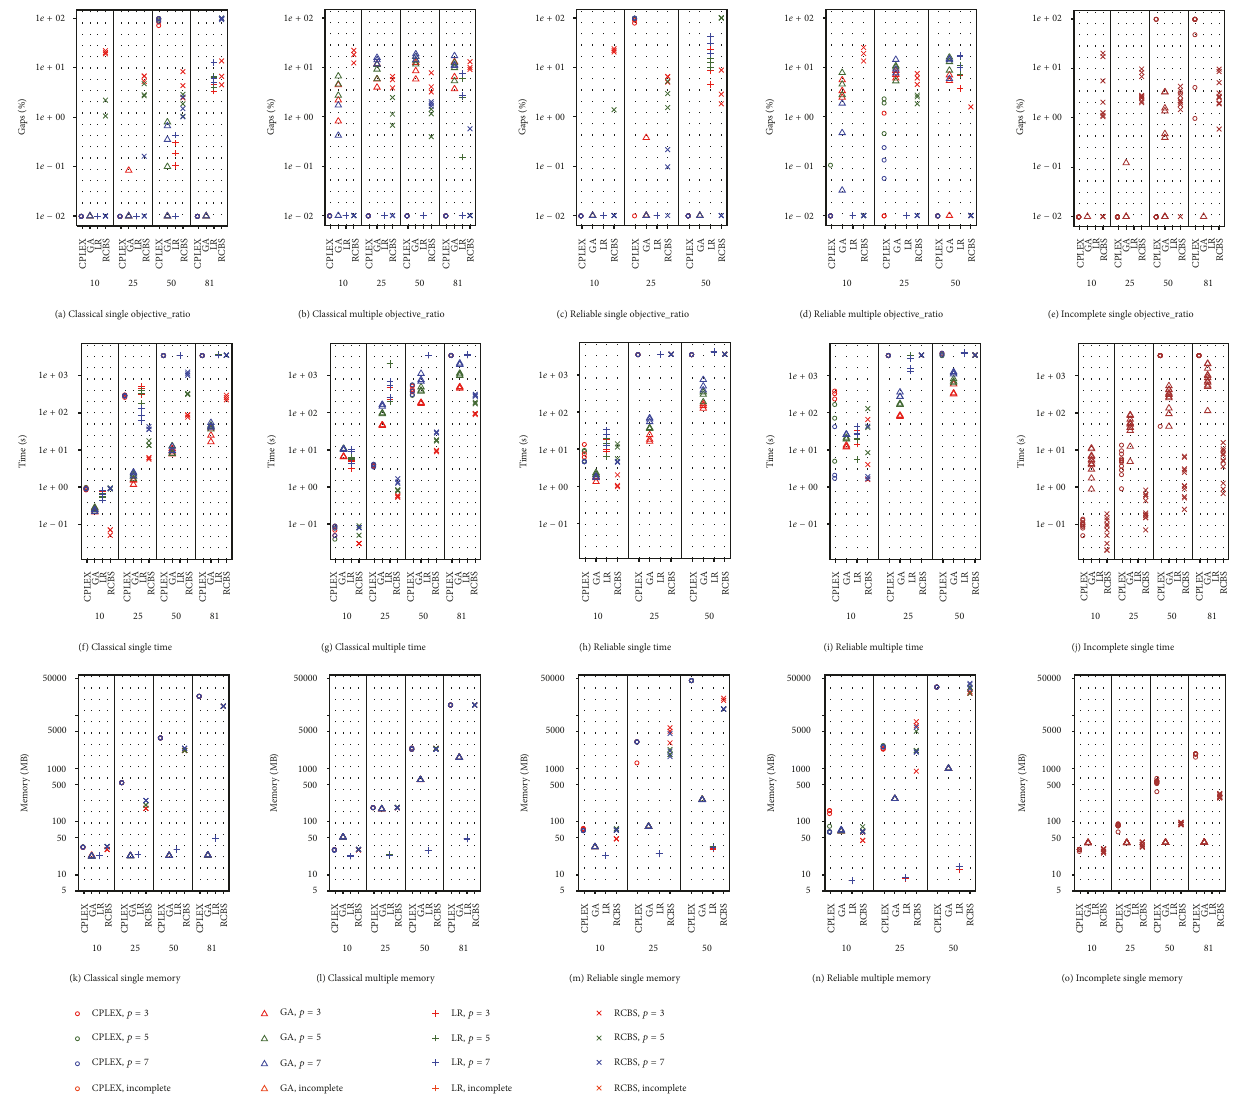
Figure 5: Results of five types of problems for TR dataset. The problems in five columns are CSA, CMA, RSA, RMA, and ISA. The measurements of three rows are solution gaps, computation time, and main memory usage, respectively. In each subfigure, the results for different numbers of nodes (𝑛 ∈ {10, 25, 50, 81}) obtained with four methods are